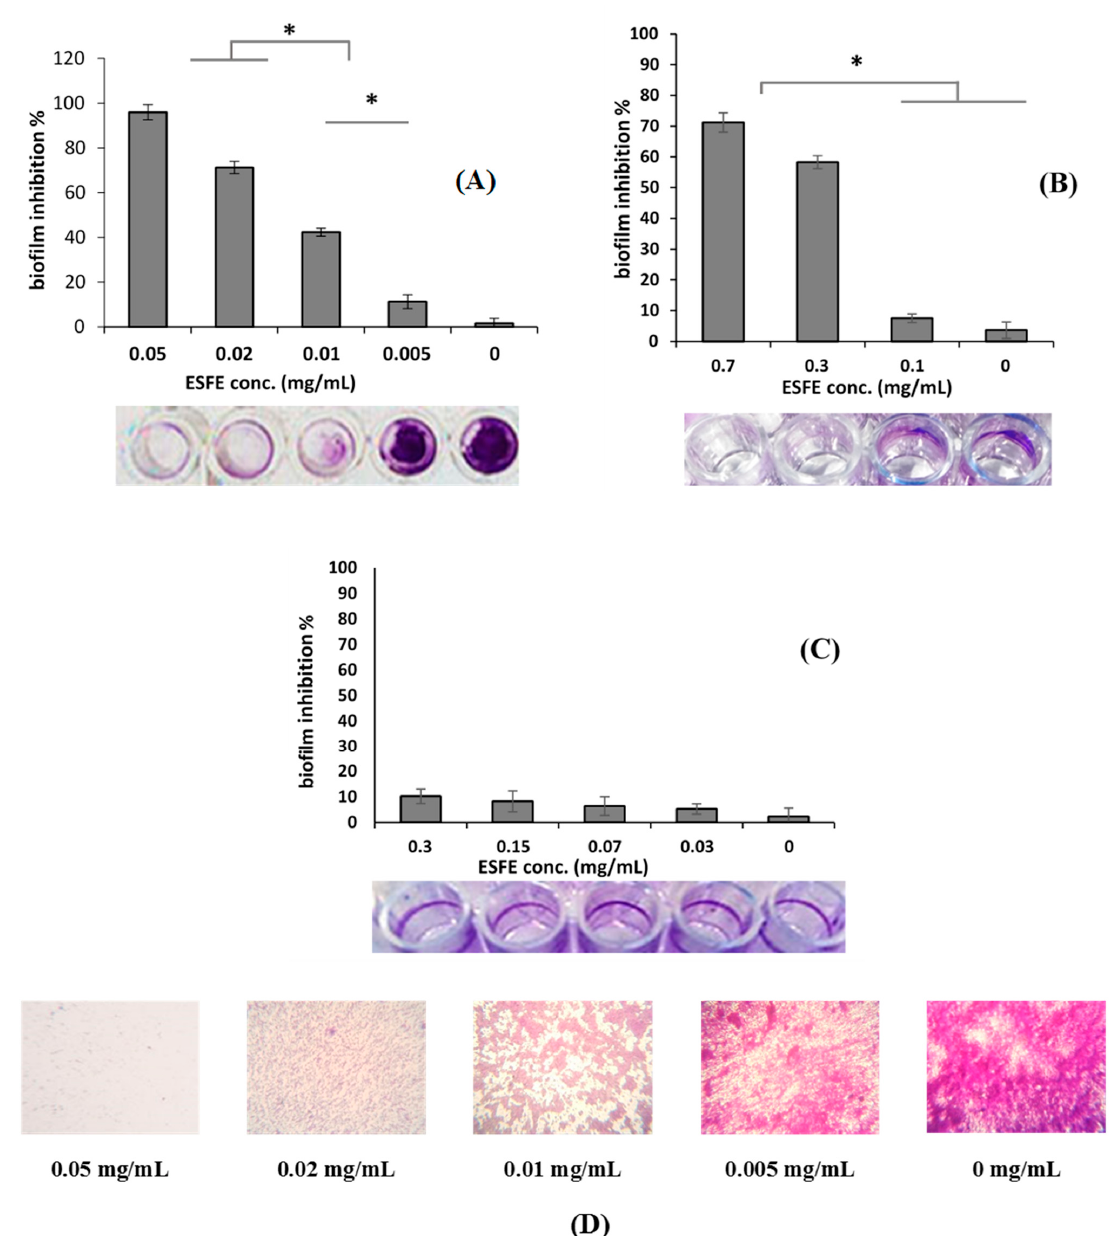
Figure 2. Biofilm inhibition percentage of E. sideroxylon flower extract (ESFE) against the biofilm formation of ( A ) S. aureus ACL51 (MRSA), ( B ) C. albicans ATCC 90028, and ( C ) P. aeruginosa ATCC 27853. ( D ) Microscopic images (×150) illustrate the effect of different sub-MICs of ESFE on the biofilm formation of the highly producing biofilm S. aureus ACL51 (MRSA). Significant differences are indicated by * p < 0.05.